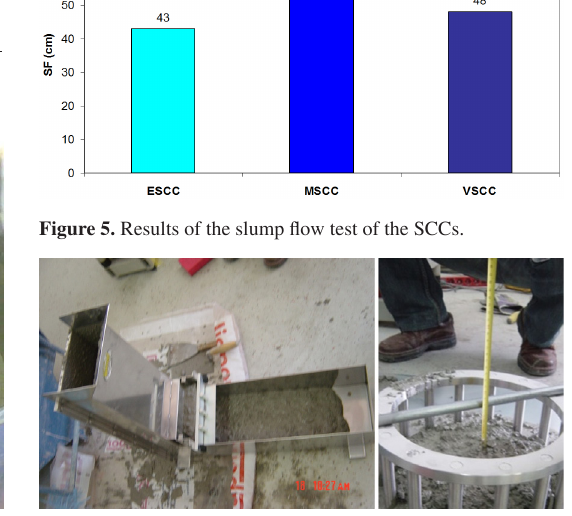
Figure 6. L-box and J-ring testing.